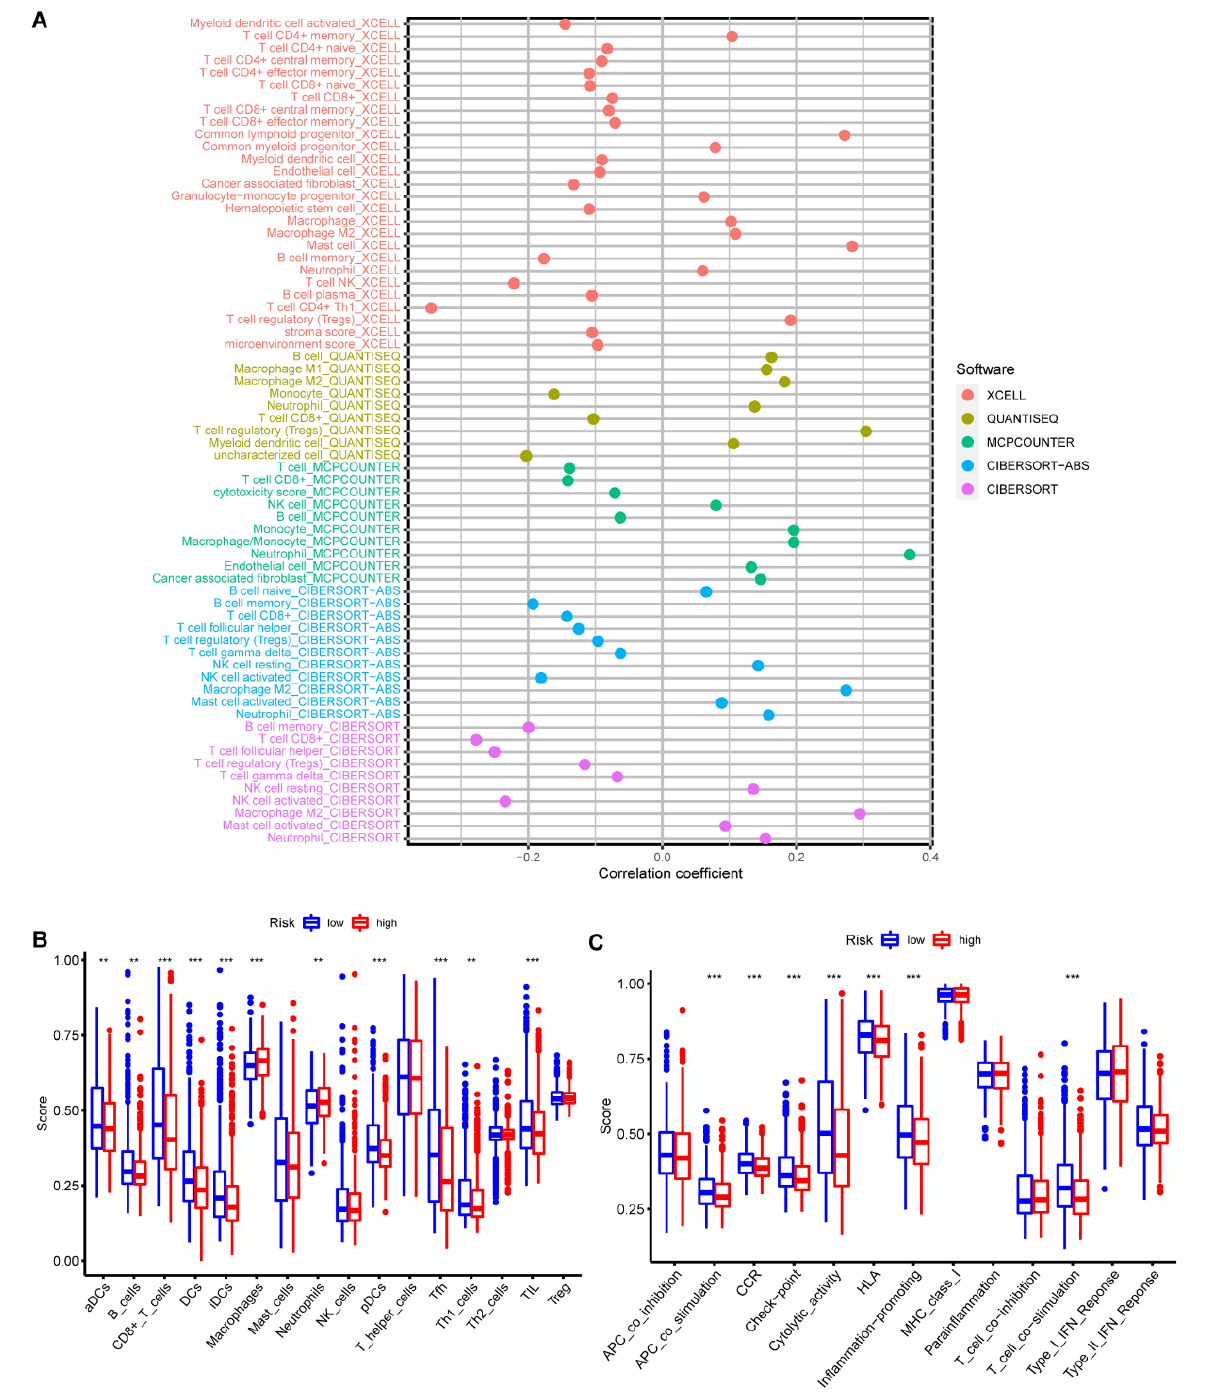
Figure 10. Comparison of ssGSEA scores for immune cells and immune pathways between high- and low-risk groups. ( A ) Differences in immune cell infiltration between high- and low-risk groups. ( B , C ) Enrichment scores of 16 immune cells and 13 immune-related pathways between the low- and high-risk groups are shown with box plots in TCGA cohorts. p < 0.01 = “**”, and p < 0.001 = “***”.